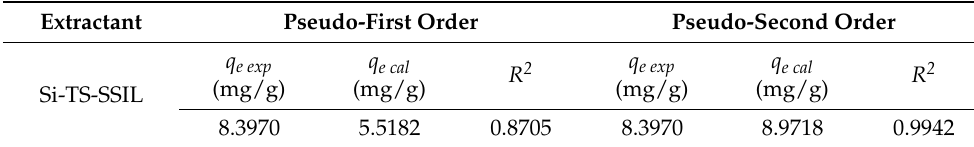
Table 4. Kinetics model for the removal of Pb(II) ions by the Si-TS-SSIL extractant.